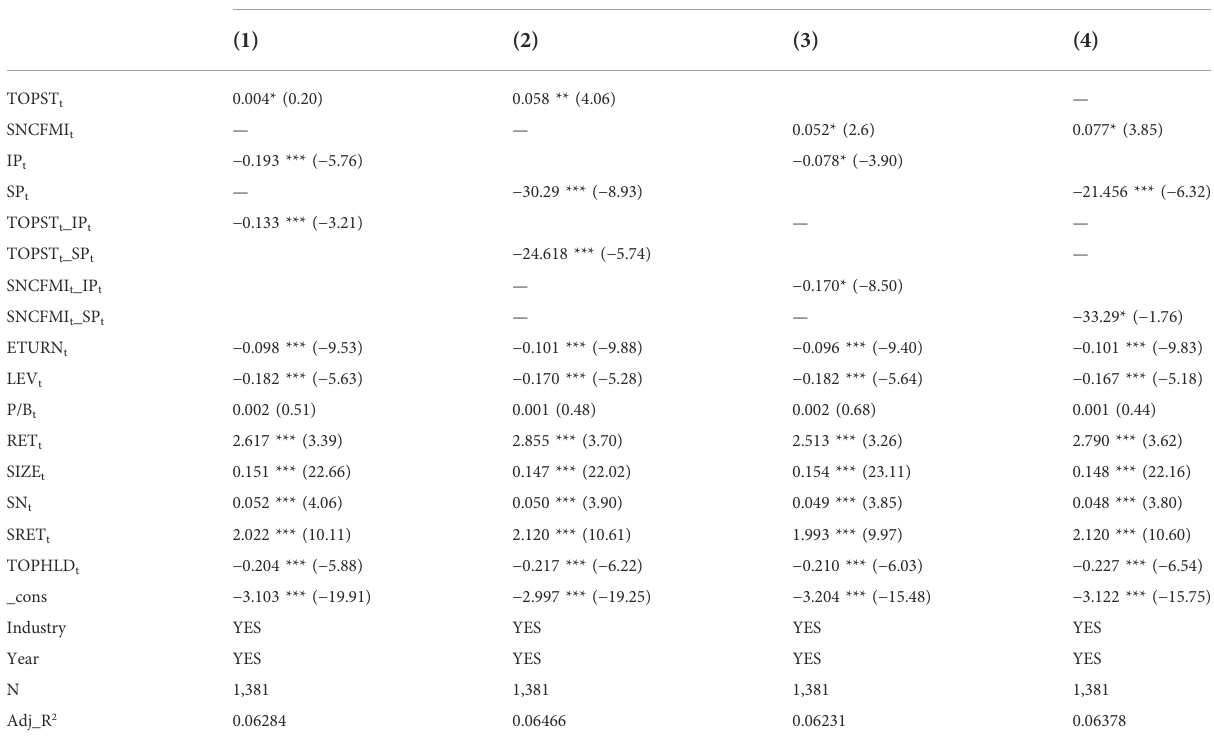
TABLE 5 Regression result of the PSM